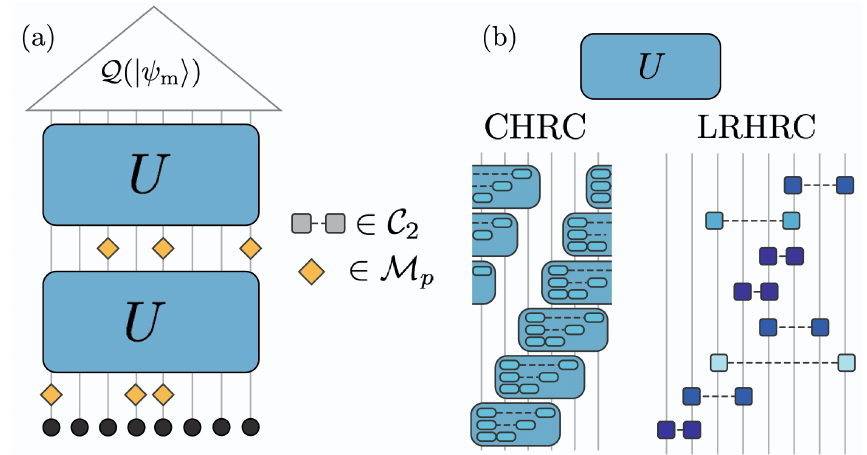
Figure 1: (a) The hybrid random circuit is composed of measurement layers in- terspersed with unitary layers. The circuit is initialized in a product state of spin variables, and, at the stationary limit, the quantity of interest Q is evaluated for the 〉 , where m is a collective index that specifies a trajectory. The quantum trajectory | ψ m ∈ C unitary evolution is build upon two body random Clifford gates U , whereas i , j 2 the projective measurement are applied on each site with probability p . If a measure- = { ( 1 + Z ) / 2, ( 1 − Z ) / 2 } . (b) ment occurs, the collapsing operator is chosen from M p Unitary layer for CHRC and LRHRC protocols. For the CHRC, we depict a periodic system of L = 6 sites: the collective unitary layer is composed of L cluster unitaries acting on M spins (big rectangles), which are build out of M − 1 two-body random cir- cuit (small rectangles). In the above illustration M = 4. (See Eq. (3) for the general definition). For the LRHRC the constituting two-body unitary gates act on i , j drawn from the lattice with probability P ( r = | i − j | ) ∝ 1 / | j − i | α . The normalization of the probability distribution P ( r ) imposes an effective Kac normalization on the system. In the cartoon in (b-Right), the different colors reflect different probability density of the associated indices ( i , j )